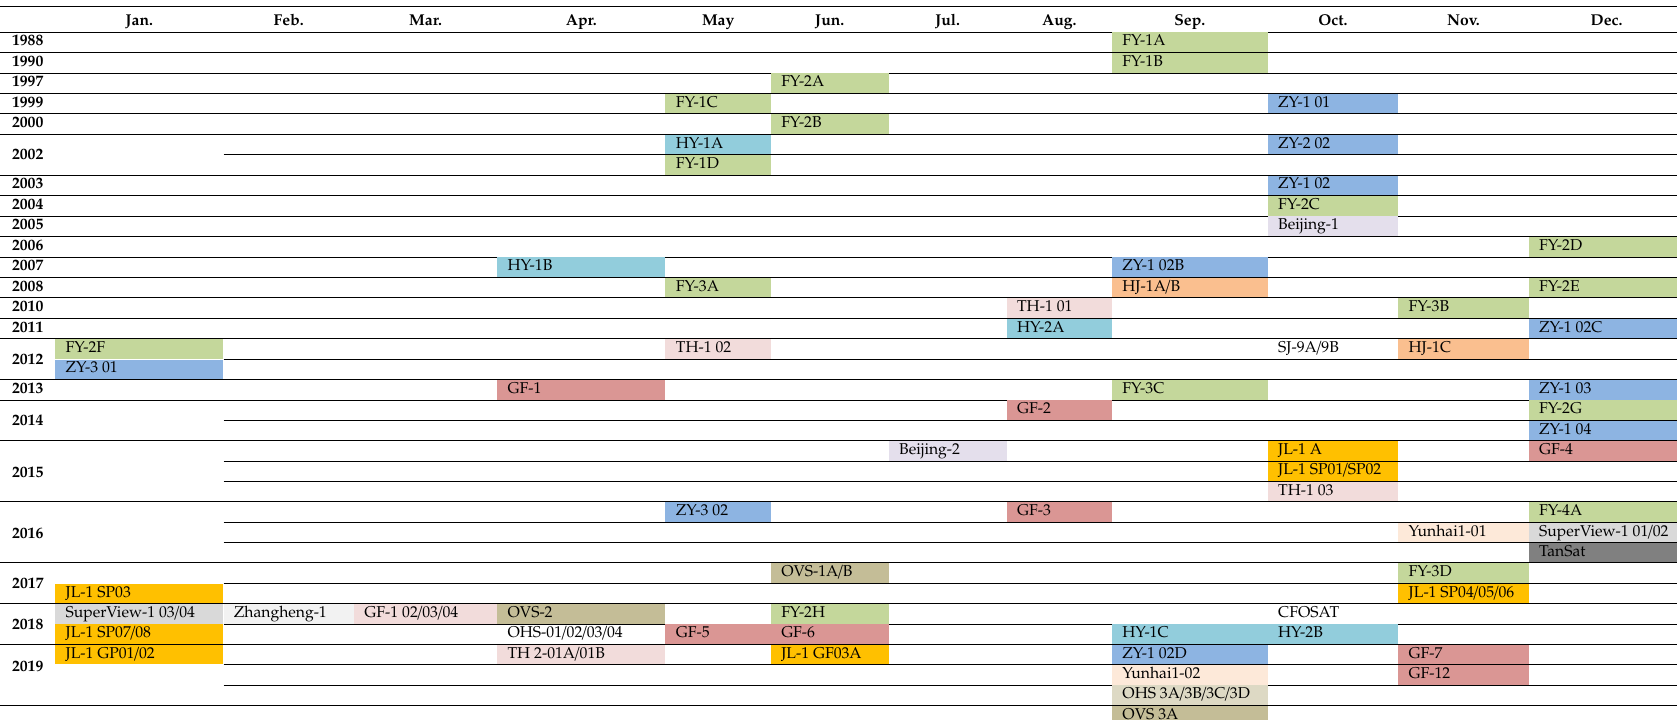
Table 1. Time series of Earth observation satellites launched by